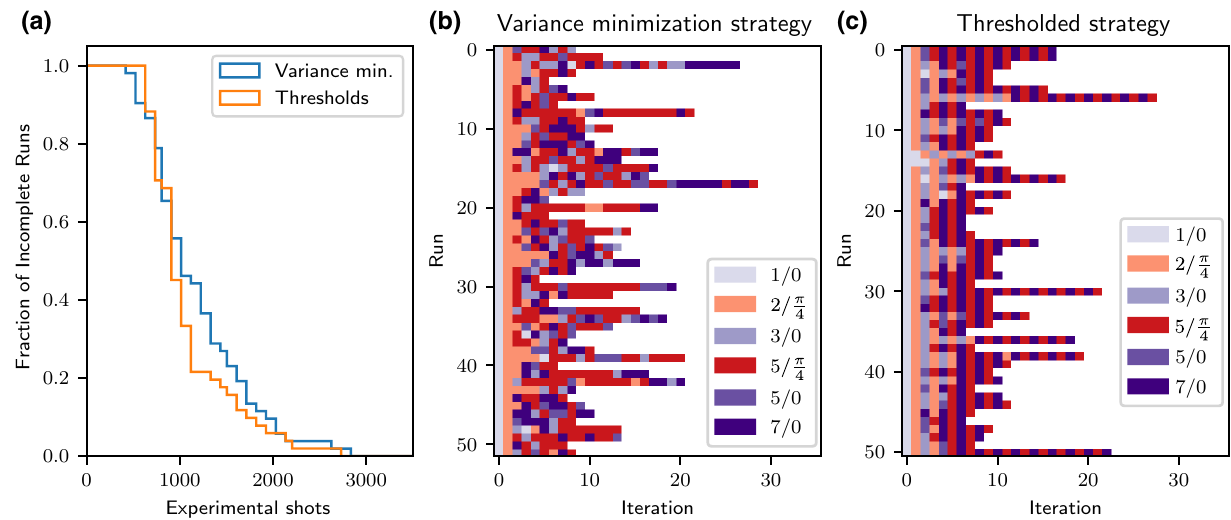
FIG. 8. The number of experimental cycles required to reach the target thresholds is shown as a fraction of all runs in (a). The thresholded strategy takes 1100 ± 500 cycles on average compared to 1200 ± 500 for the variance minimization strategy. Panels (b) and (c) show the measurement settings used during the calibration runs for the respective strategies, with the y axis corresponding to independent runs and the x axis to iterations of the algorithm during a calibration run; at each iteration 100 measurements are performed with the chosen setting. The colors indicate the measurement setting used at a given iteration of a run, characterized by the number of gates N g (first number in the legend) and the selected phase difference (cid:13)ϕ target (second number) used for the gate sequence.